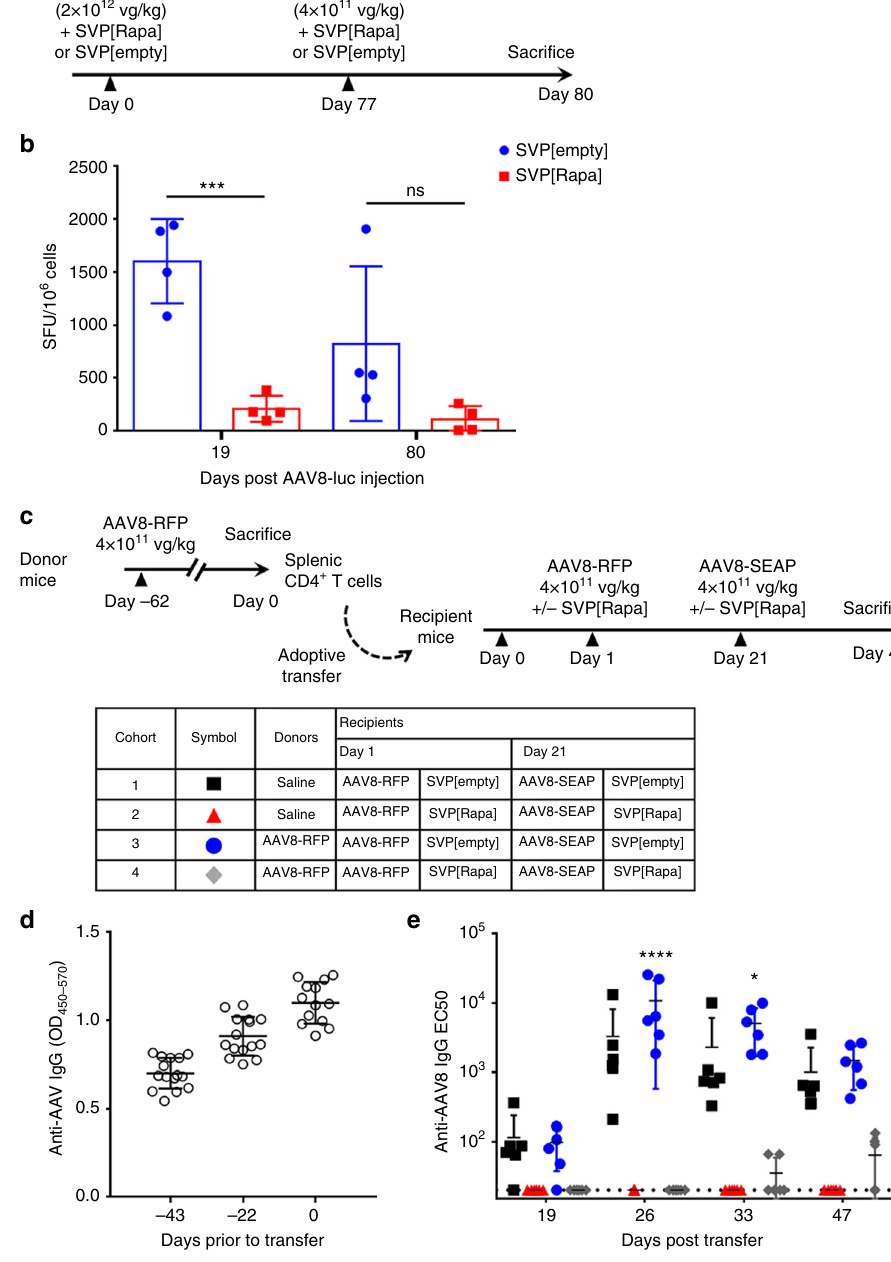
Fig. 5 Control of anti-AAV8 capsid memory T cell responses with SVP[Rapa]. a Protocol outline. Male C57BL/6 mice ( n = 4) were treated i.v. with